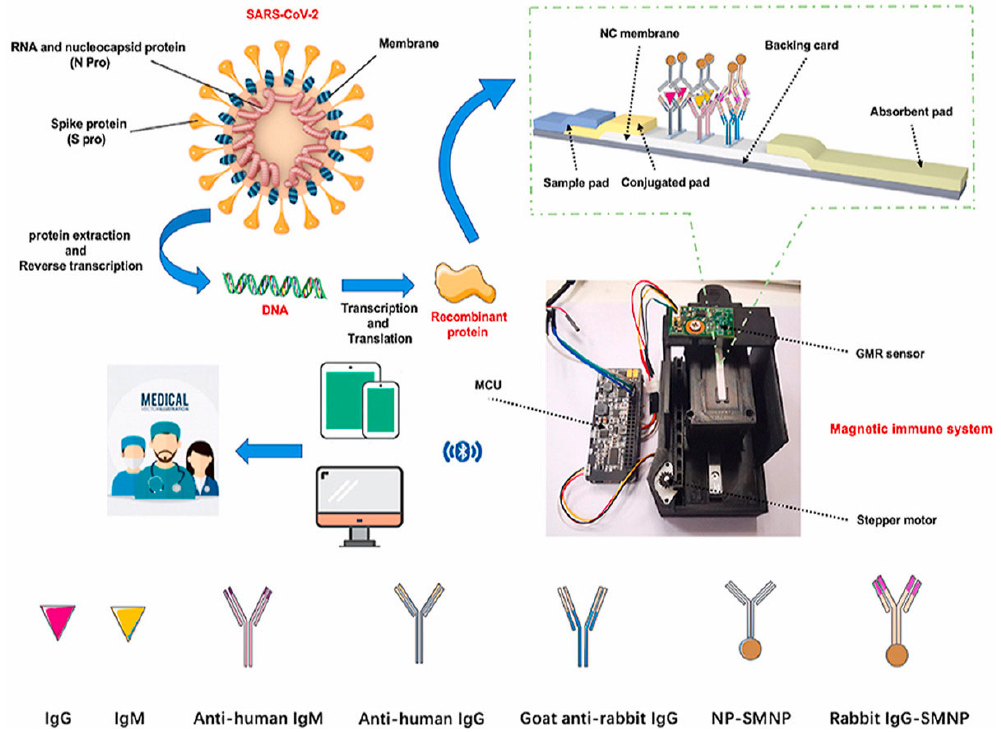
Figure 11. Composition of SARS ‐ CoV ‐ 2 virus, the scheme for detection of anti ‐ SARS ‐ CoV ‐ 2 immunoglobulin M (IgM) and G (IgG)using the test strip, the magnetic immune system device, and medical applications (reprinted with permission from [134]).